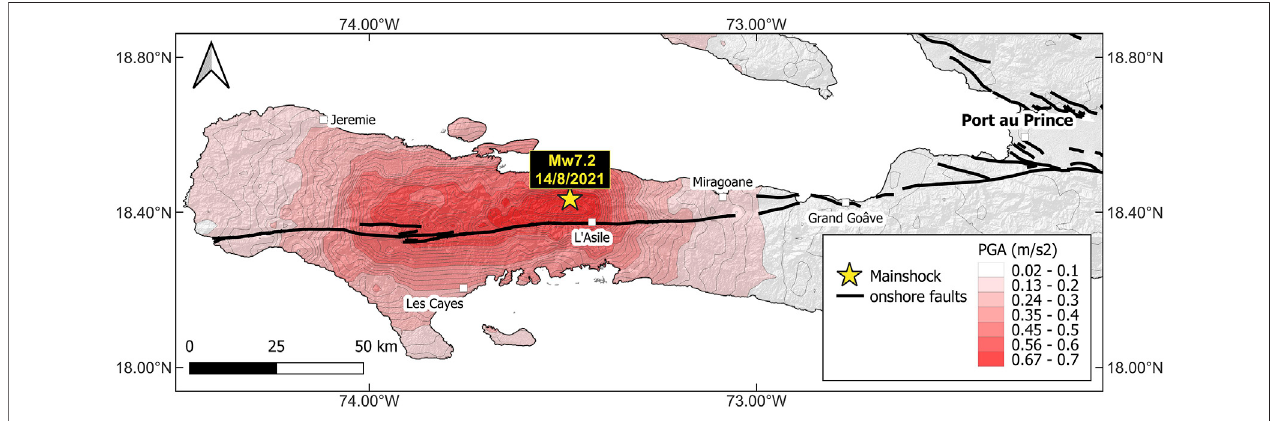
FIGURE 5 | Peak Ground Accelerations for the 2021 earthquake modelled by the USGS (USGS, 2021). Darker reds indicated higher peak ground accelerations. The ~70 km length of the fault plane used for fi nite fault modelling leads to an approximately east-west striking band of predicted high peak ground